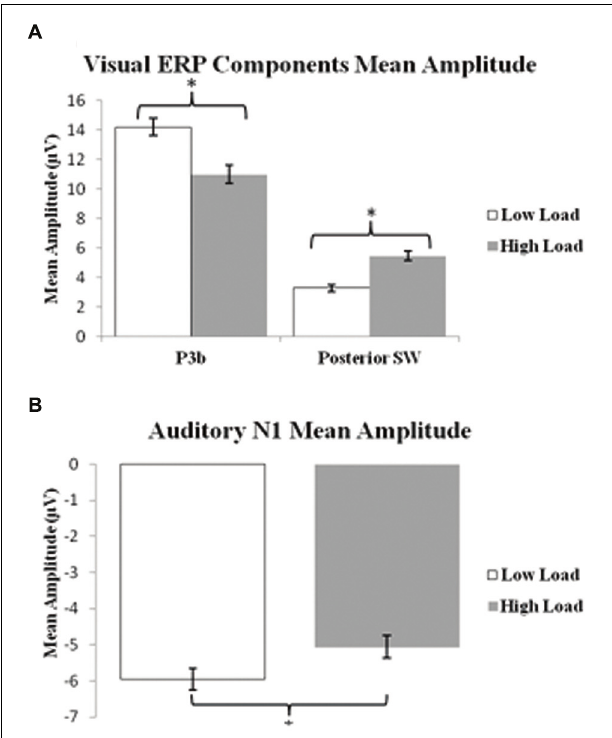
FIGURE 3 | Bar graphs illustrating the mean amplitudes of the ERP components under the low and high load conditions. (A) Shows mean amplitude of P3b component and posterior SW in response to target visual stimuli; and (B) illustrates mean amplitude of the N1 component in response to standard auditory stimuli. Error bars indicate standard error of the mean. ∗ p <